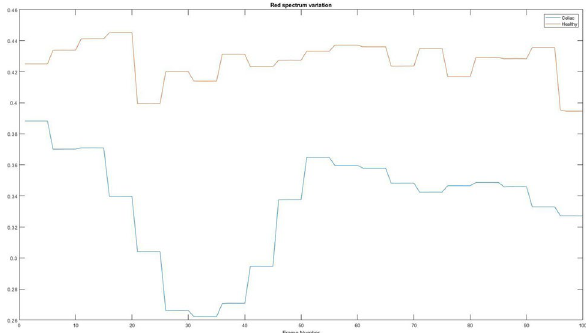
Figure 14. Red spectrum variation. Red = Healthy and Blue = Celiac.